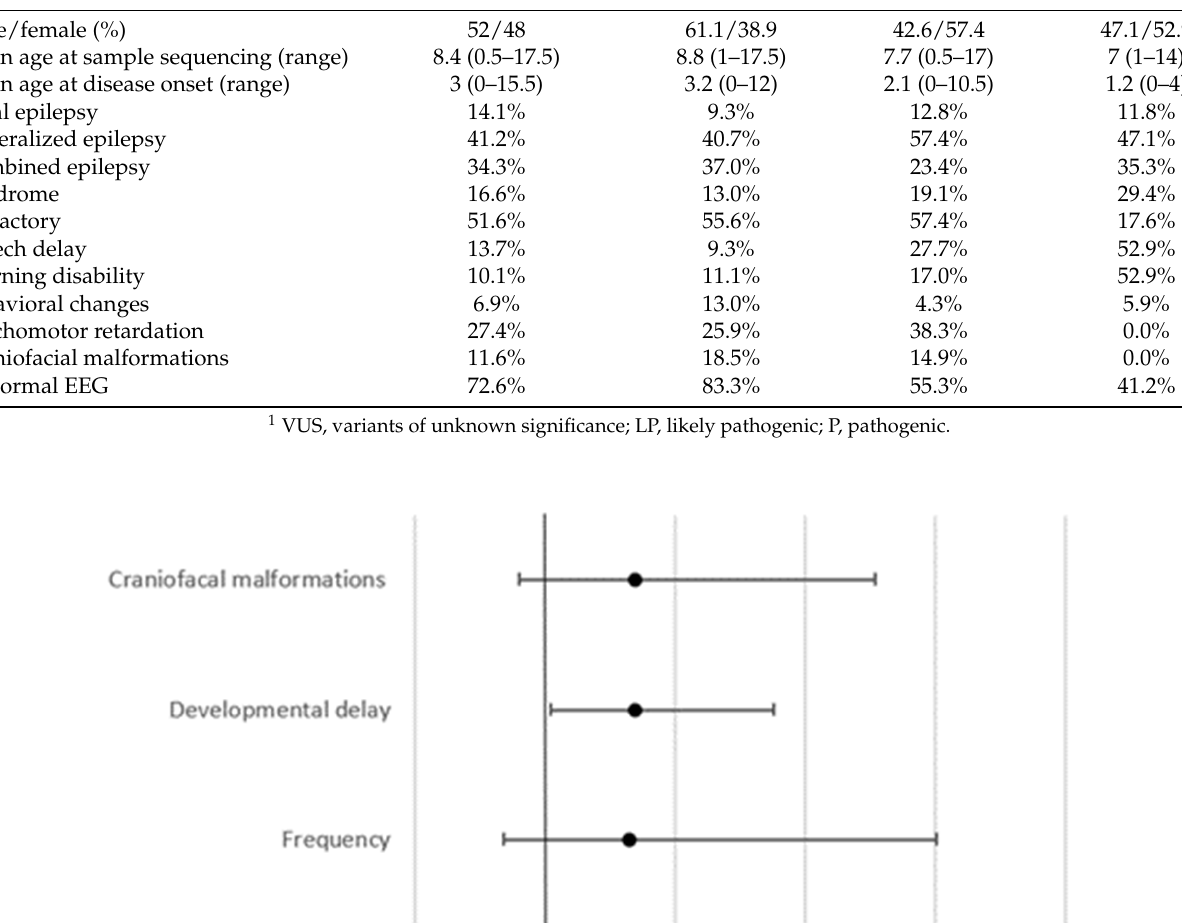
O n s e t age Figure 2. Significantly different age at onset between groups of patients stratified according to variant annotation. Although variants were analyzed with a panel consisting of 142 genes, variants in only 47 genes have been detected in this group of 277 patients. Of 118 variants described, 38 (32.2%) were not described in the literature. Those 38 variants were present in 25 genes. One novel variant in the ALDH7A1 gene, 1566-1G>T, rs140845195) was present in four patients. The genes with repeated novel variants were ADGRV1 , ALDH7A1 , KCNT1 , MBD5 , SCN2A , SCN8A , TBC1D24 , and TSC2 .